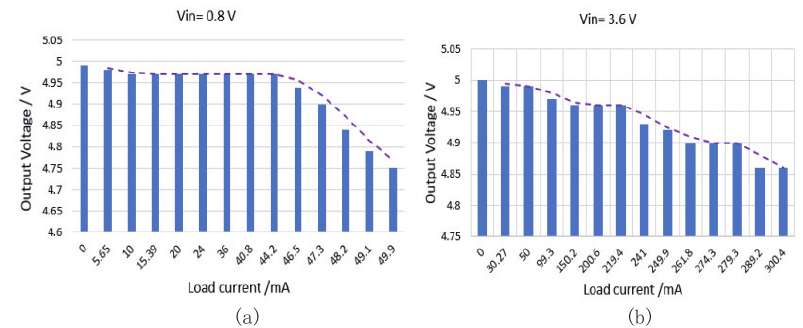
Figure 17. The the test results of output voltage variation with load current when the input voltage is identified. ( a ) The input voltage is 0.8 V. ( b ) The input voltage is 3.6